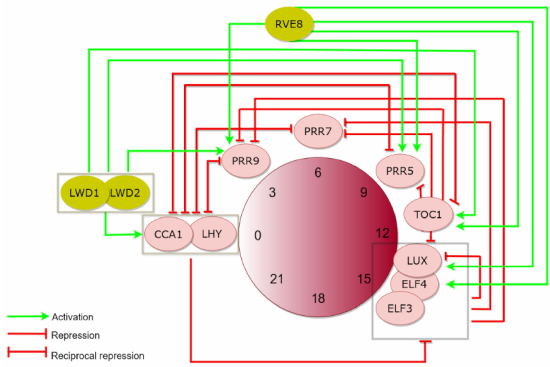
Figure 1. Schematic drawing depicting the basic regulatory network at the core of the Arabidopsis circadian oscillator. Oscillator genes are expressed at di ff erent phases during the day and night, from morning hours on the left on the central circle (clock) to evening hours on the right. Repression is depicted as red lines ending in small perpendicular dashes whereas activation is indicated by the green arrows. Clock components that interact to perform their regulatory function are encircled in grey line boxes. CCA1 and LHY are repressors of PRR genes, including TOC1. PRRs in turn repress the expression of CCA1 and LHY. Expression of Evening Complex (EC) components ( LUX , ELF4 , ELF3 ) is repressed by both CCA1 / LHY and TOC1. The EC represses expression of PRR9 , PRR7 , and LUX. The regulatory network is dominated by repressive interactions, although recent studies have uncovered a number of activating factors such as LWD1 / 2 and RVE8, which activate the expression of multiple morning- and evening-expressed oscillator genes. Please consult the main text for further